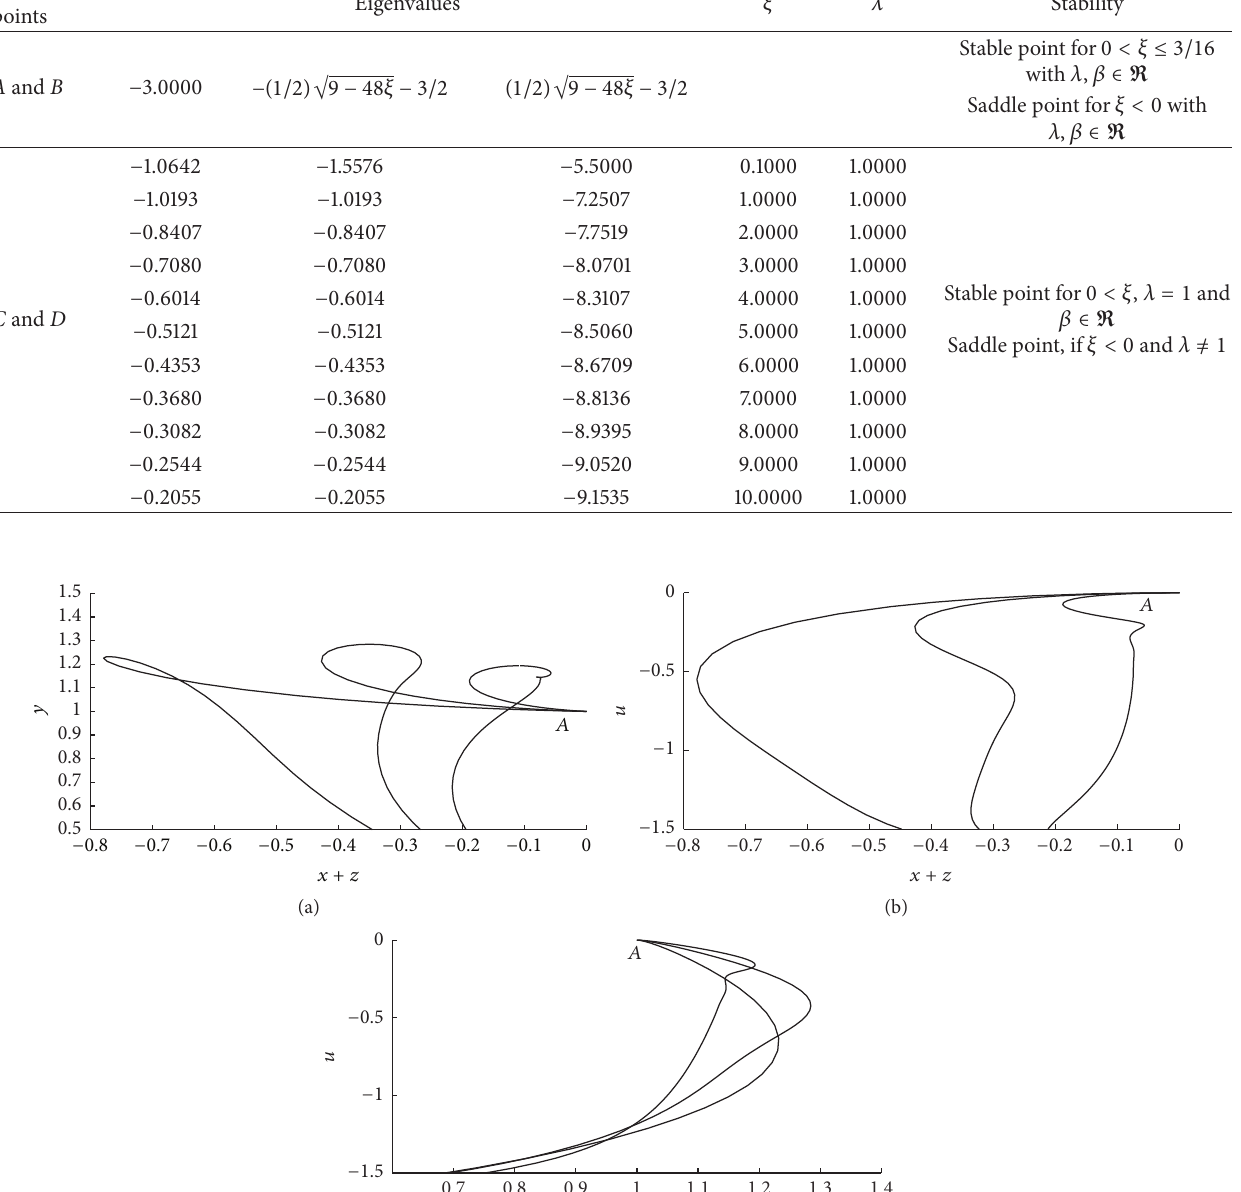
since 𝜔 tot = −1 < −1/3 , but this point refers to contraction phase because 𝑦 is negative here. For the stability of the point 𝐵 , it is again stable for 0 < 𝜉 ≤ 3/16 with 𝜆, 𝛽 ∈ R , but it is a saddle point for 𝜉 < 0 . Therefore the stable attractor